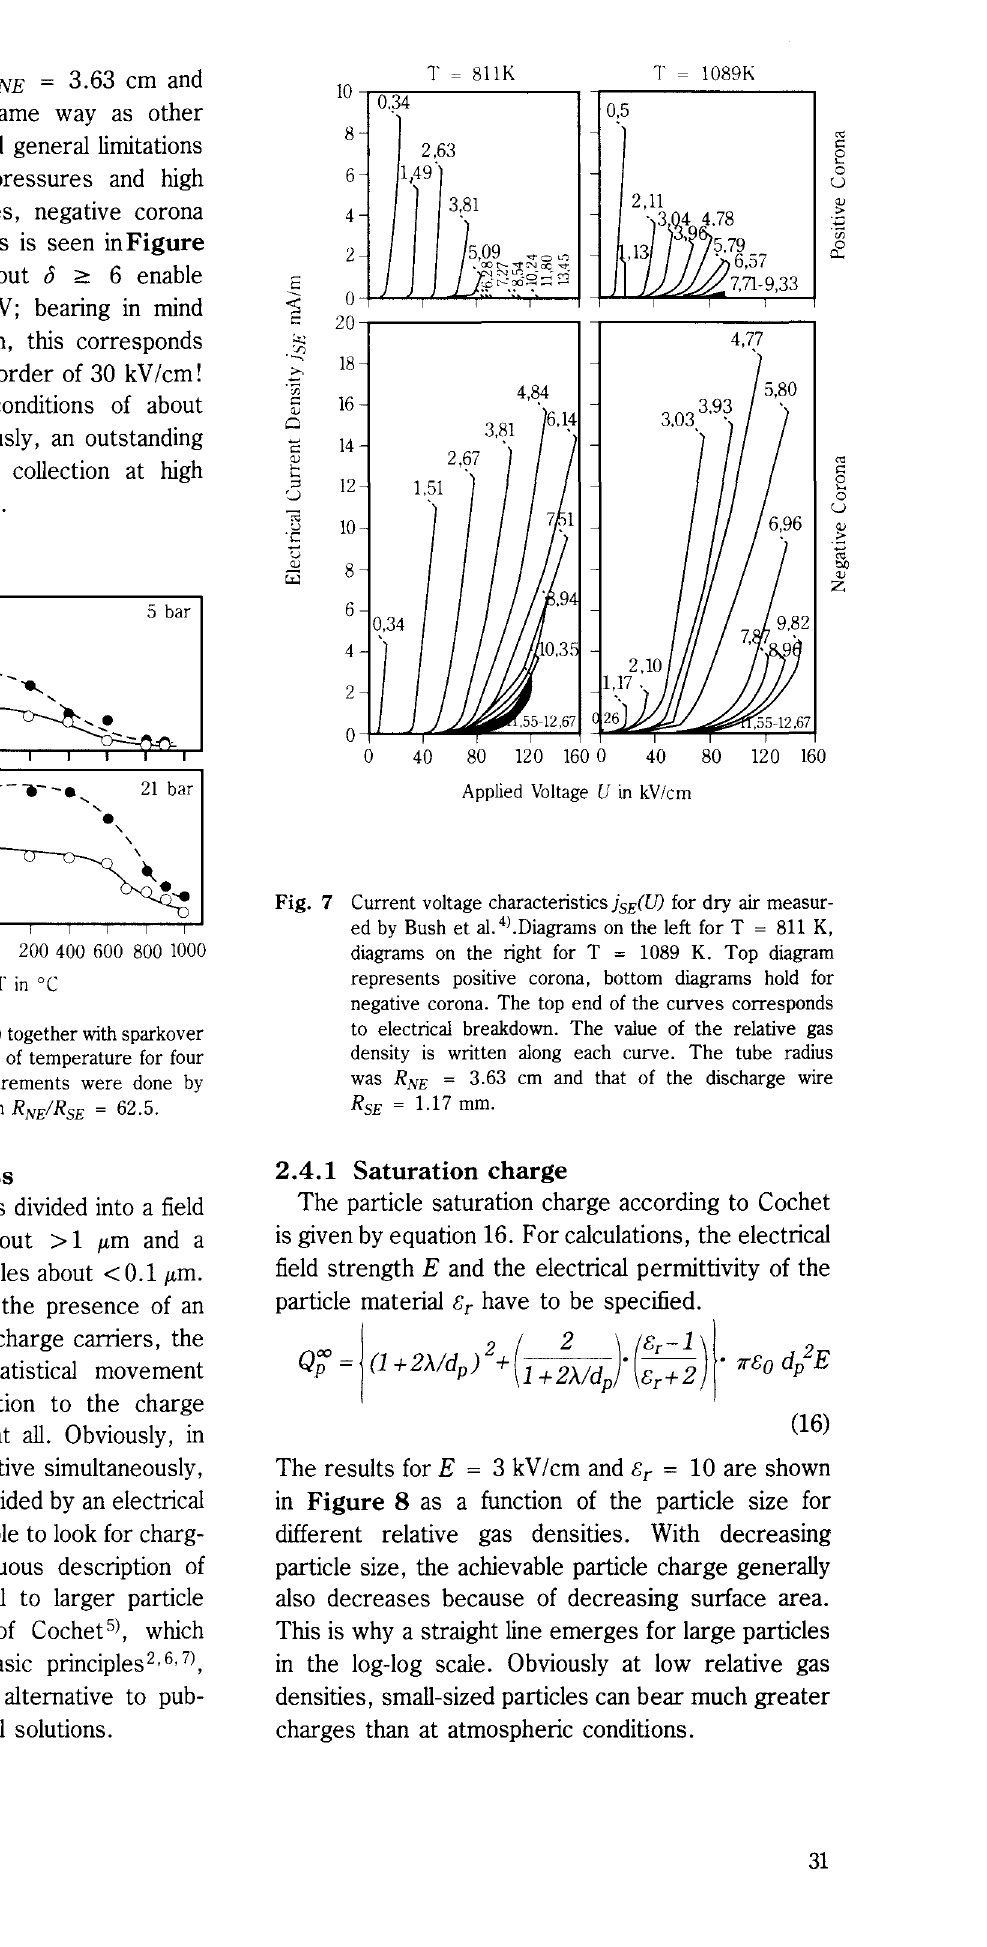
Fig. 7 Current voltage characteristics isE(U) for dry air measur ed by Bush et a!. 4 ) .Diagrams on the left for T = 811 K, diagrams on the right for T = 1089 K. Top diagram represents positive corona, bottom diagrams hold for negative corona. The top end of the curves corresponds to electrical breakdown. The value of the relative gas density is written along each curve. The tube radius was RNE = 3.63 em and that of the discharge wire RsE = 1.17